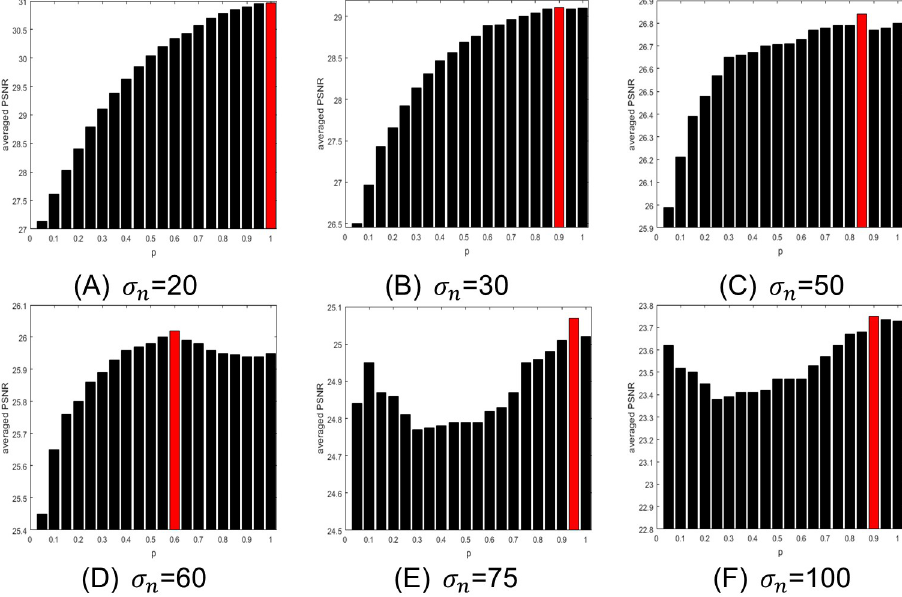
Fig 3. The influence of changing p upon denoised results under different noiselevels. (A) σ